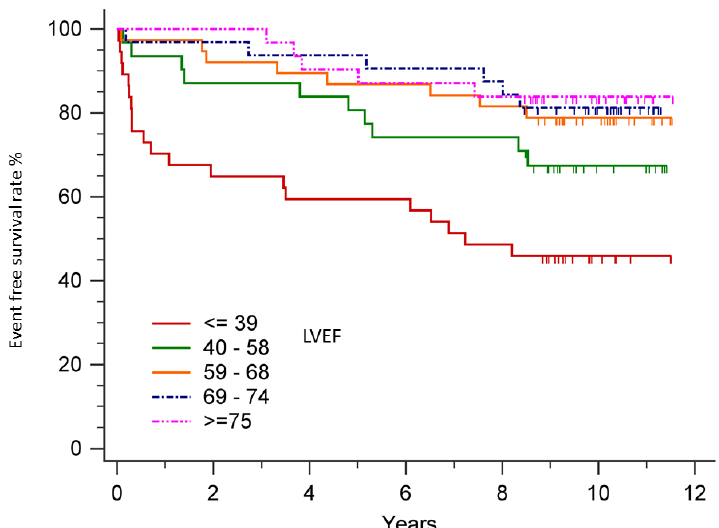
Figure 4. The Kaplan–Meier analysis of five groups of patients with di ff erent LVEF. Only patients with LVEF ≤ 39 had significant survival di ff erence when compared with other groups. LVEF: left ventricular ejection fraction.